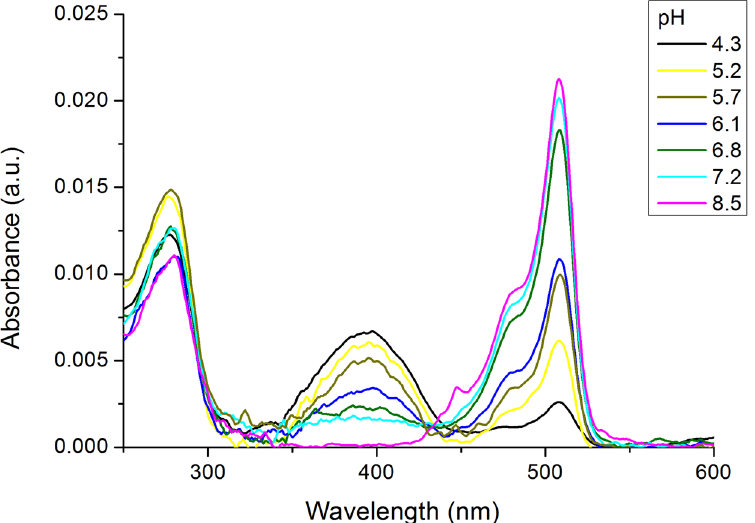
Figure 5. Absorption spectra of the V127T variant of SAASoti in 200 mM sodium phosphate buffers with varying pH.